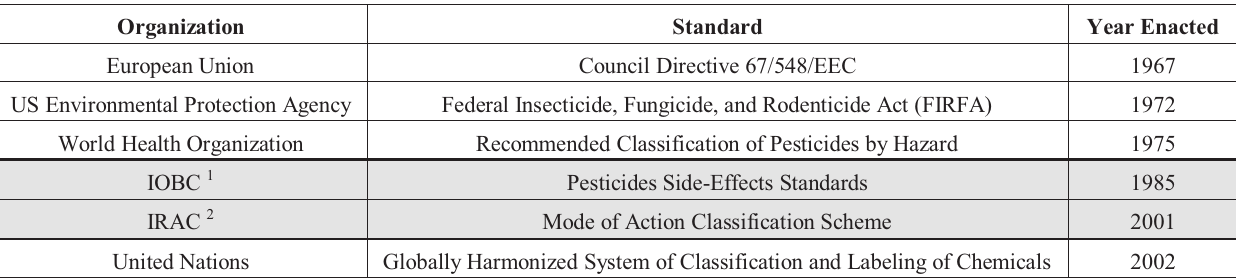
Table 1. An overview of the insecticide classification schemes in use today. Note all but the two schemes in the shaded rows base their classification on vertebrate toxicity.